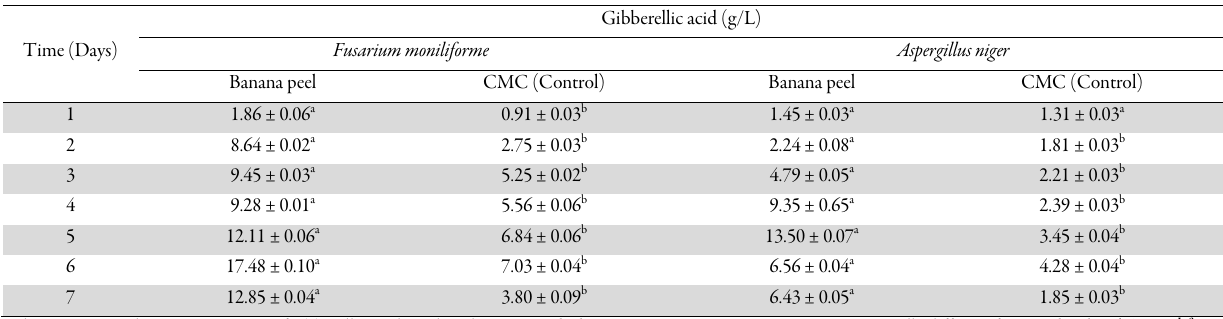
Values represented are means ±SEM of gibberellic acid produced. Means with the same superscript in a row are not statistically different from each other ( F. moniliforme and A. niger were compared